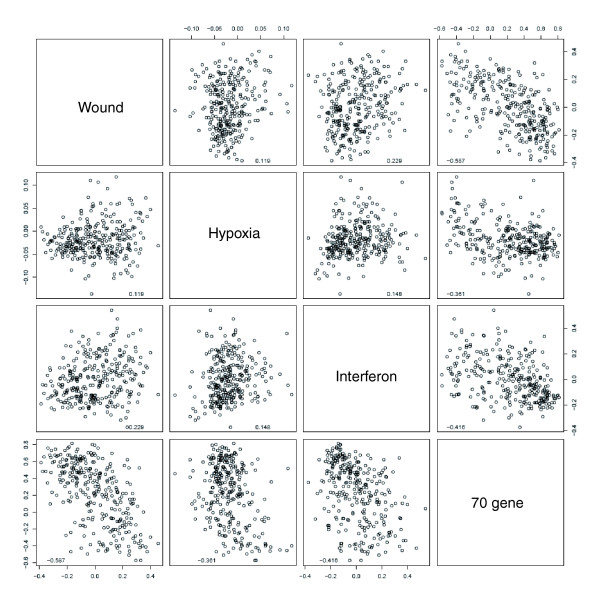
Correlation of the 70 genes signature [38], the wound signature [24], the hypoxia signature [25] and the interferon response score in the NKI dataset. Pairwise scatterplot-matrix of four gene signatures. Pearson correlations are shown in the lower part of each plot.